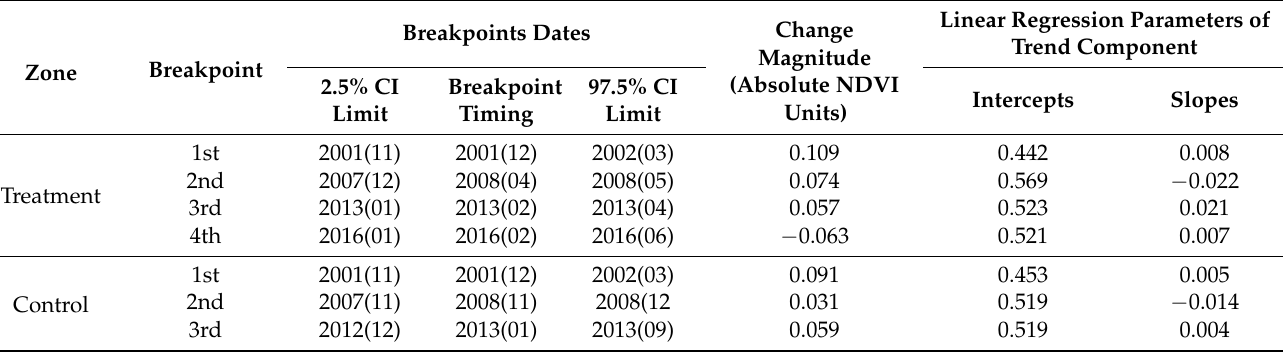
Table 1. Timing and NDVI magnitudes of breaks in the trend component of Sa Dragonera (treatment zone) and Mallorca (control zone) time series. The left and right limits of the breakpoint dates indicate a 95% confidence interval of date estimation. 1 = Timing indicated by year and month. Data format: Year (Month). 2: Difference between the NDVI value at the end of a linear model and the intercept of the next one. 3: Linear regression parameters of segments after the breakpoints date, where the intercept represents the starting NDVI, and the slope represents the greening (+) or browning (-) ratio of the vegetation. The parameters of the starting segment are omitted in this